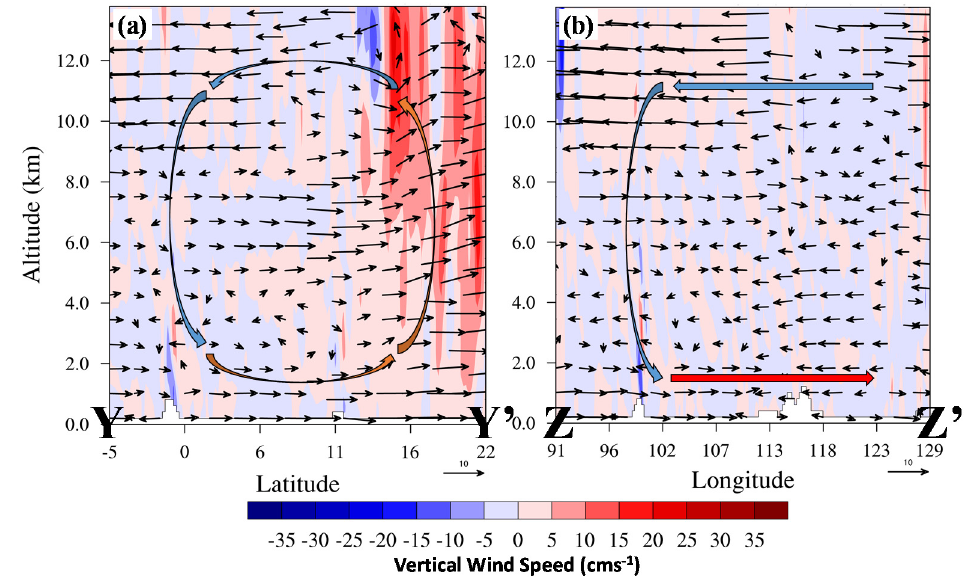
Figure 10. Wind fields (m s − 1 ) (arrows) and vertical wind speed (cm s − 1 ) (shaded colours) on 22 June along ( a ) YY’ and ( b ) ZZ’. The coloured red and blue arrows represent the overall convective cells that occur along each respective cross ‐ section.